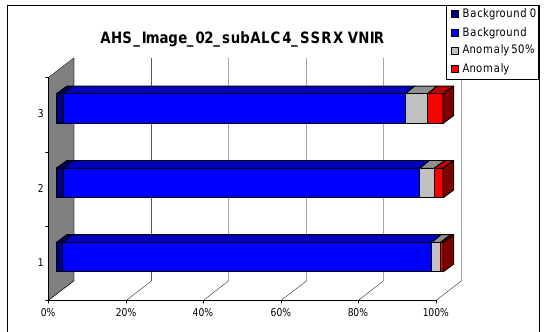
Figure 5. Example of comparison of SSRX anomalies from VNIR AHS image of Alcalá de Henares: (1) Town, (2) Industrial and (3) Semi-urban areas.